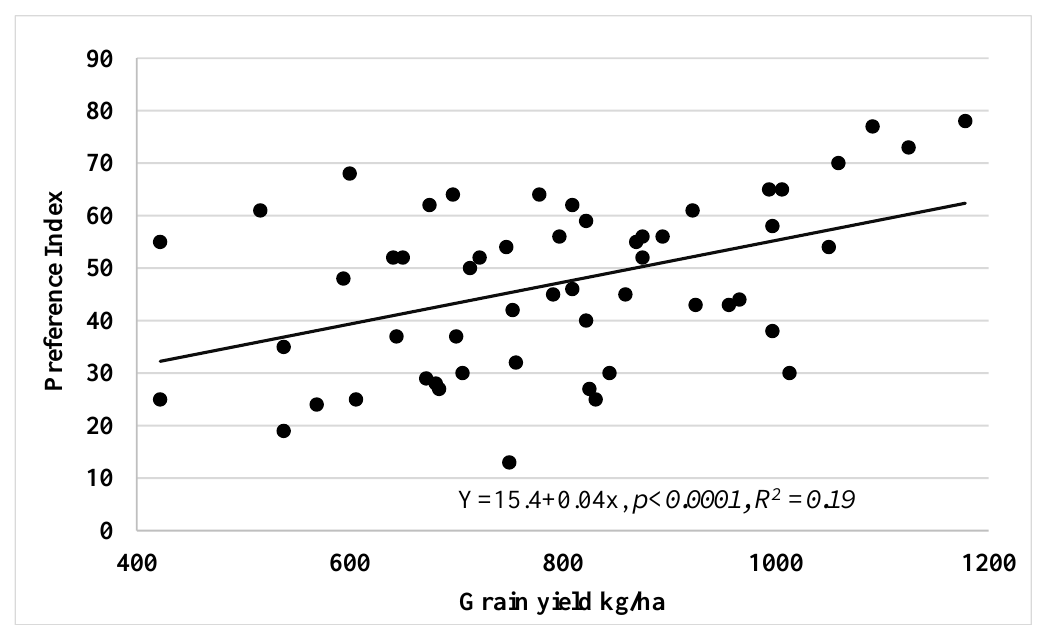
2013/2014 season ( R 2 = 0.19). The four varieties that had the highest yield were also those with the highest PI (Figure 8).